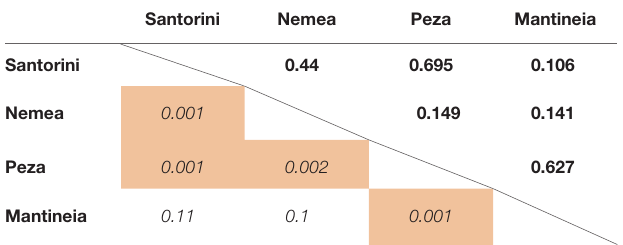
TABLE 1 | Analysis of Similarity (ANOSIM) and Permutational multivariate analysis of variance (PERMANOVA) of the factors “region,” “vintage,” and “vineyard” on wine yeast diversity patterns.